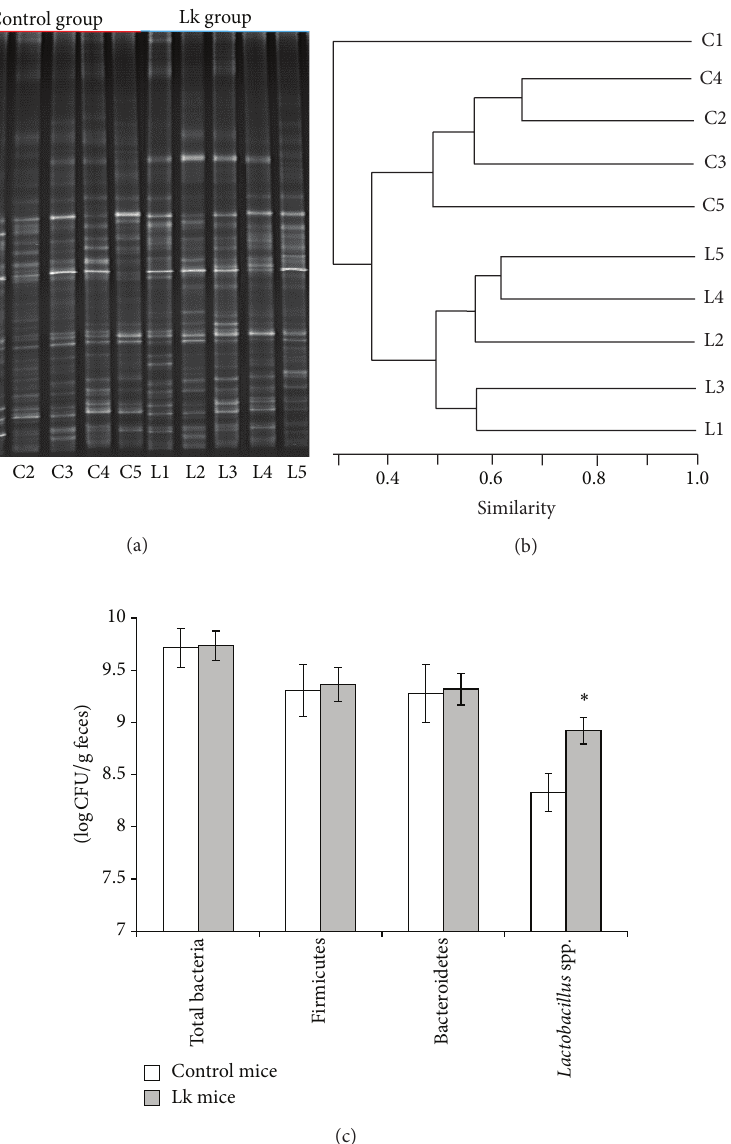
Figure 6: Evaluation of microbiota on fecal samples taken on the 21st day of trial from control and Lk groups. (a) Total bacteria DGGE profiles of five mice from control group (lanes C1 to C5) and five from Lk group (lanes L1 to L5). (b) Dendrogram for the total bacterial DGGE profiles. Clustering analysis was performed using the UPGMA linkage. (c) qPCR quantification of total bacteria, Firmicutes, Bacteroidetes, and Lactobacillus spp. Results are expressed as mean ± standard deviation. ∗ 𝑃 < 0.05